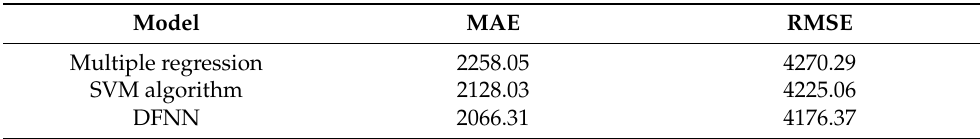
Table 4. Model comparison between MAE and